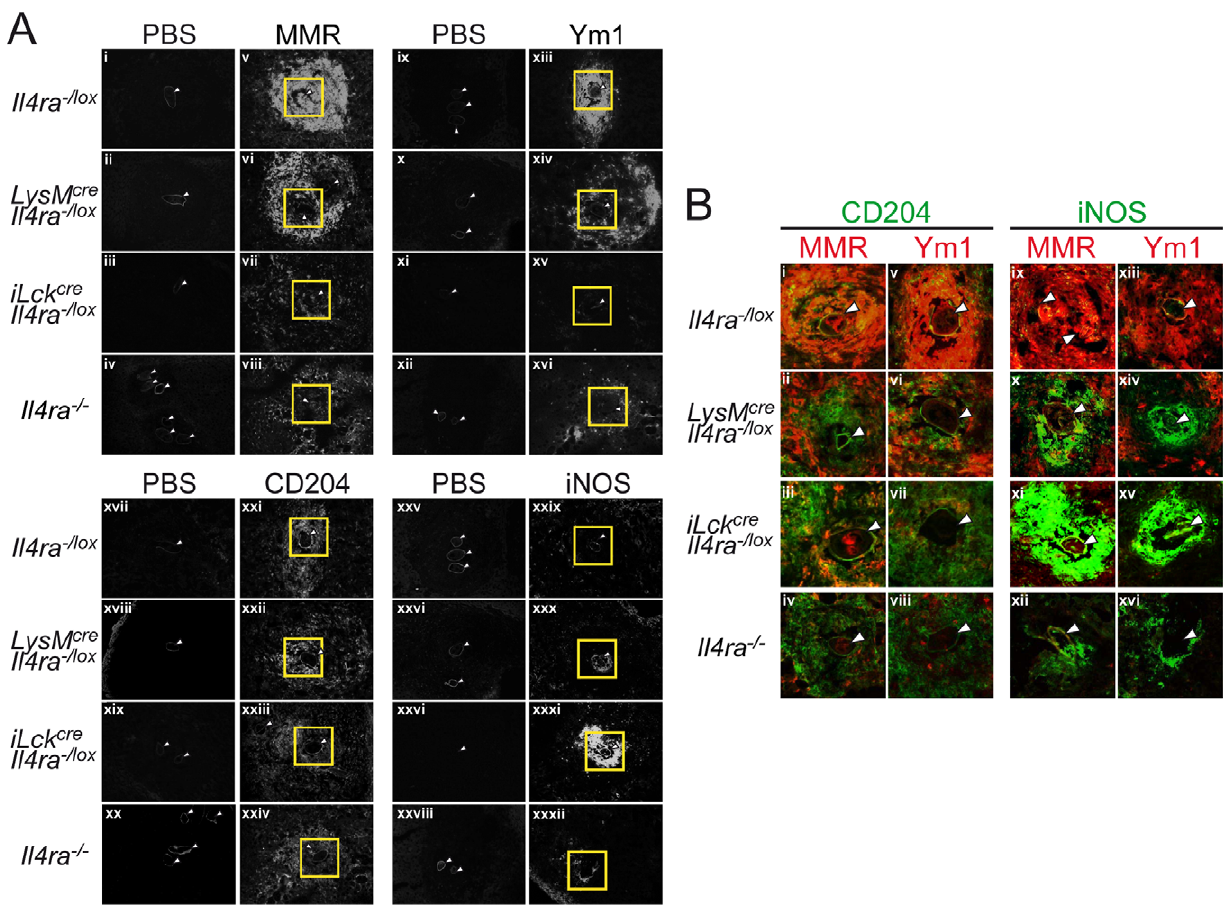
Figure 4. Localisation of mannose receptor and Ym1-expressing granuloma macrophages in close contact with S.mansoni eggs depends on their IL-4R a signalling. Livers were collected at 8 weeks p.i. from Il4ra 2 /lox , LysM cre Il4ra 2 /lox , iLck cre Il4ra 2 /lox and Il4ra 2 / 2 mice and immunofluorescent stainings performed on cryosections. (A) Representative micrographs of MMR (panels v–viii), Ym1 (panels xiii–xvi), CD204 (panels xxi–xxiv) and iNOS (panels xxix–xxxii) stainings of liver cryosections as described in Methods. Stainings with secondary antibody (MMR, iNOS), streptavidin alone (Ym1) or isotype-control (CD204) is shown for each corresponding staining (MMR=i–iv, Ym1=ix–xii, CD204=xvii–xx, iNOS=xxv–xxviii). Note that MMR + and Ym1 + cells are restricted to the periphery of LysM cre Il4ra 2 /lox granulomas. Outlined regions represent the areas magnified in B. (B) Representative micrographs of liver cryosections stained with scavenger receptor (CD204) for macrophages detection (panels i–viii, green) or iNOS for classically activated macrophages detection (panels ix–xvi, green); and co-stained for MMR (panels i–iv and ix–xii, red) or Ym1 (panels v–viii and xiii–xvi, red). Note the low frequency of CD204 + macrophages co-expressing MMR + or Ym1 + cells around the parasite eggs (panels ii and vi) but the high levels of iNOS + cells (panels x and xiv) in LysM cre Il4ra 2 /lox mice, suggesting these macrophages to be classically activated. White arrows indicate the parasite eggs. Original magnification: 400 6 . Data represent one of three independent